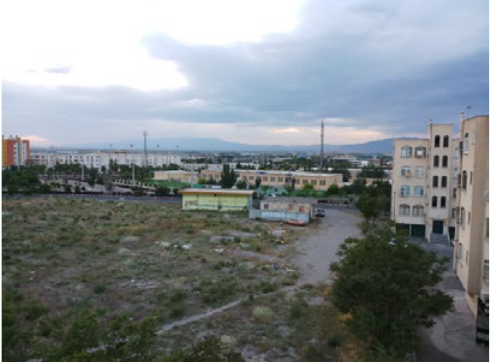
Fig. 3: Wastelands and perspective of industrial land use